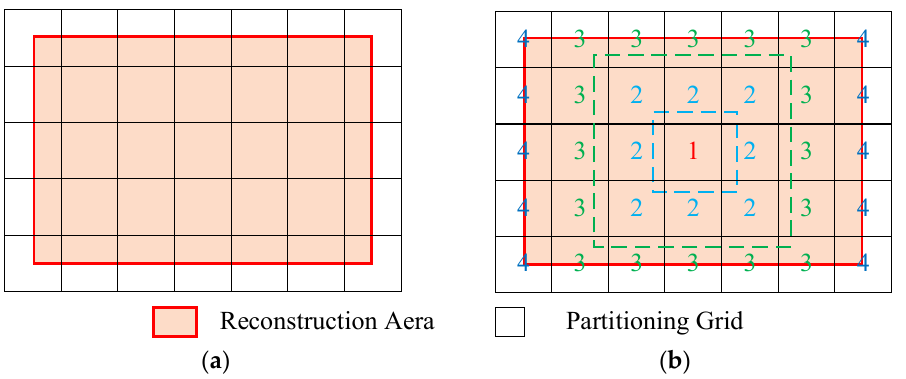
Figure 4. Calculation of hierarchical relationships. ( a ) Original partition grids and their reconstruc ‐ tion areas and ( b ) the hierarchical relationship calculation for reconstruction.